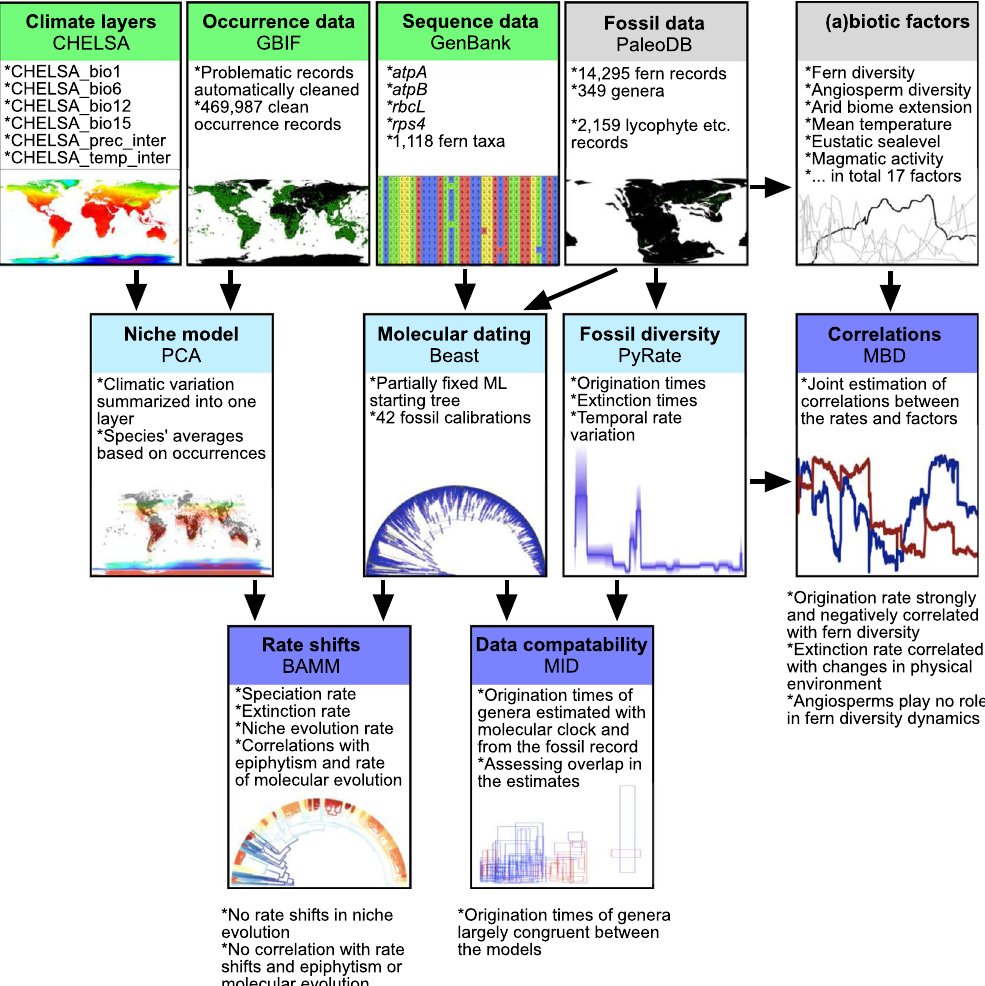
Figure 1. Analytical workflow developed for this study. We used neontological (green) and palaeontological (grey) data sources to model fern diversification dynamics. In the first round of analyses (pale blue) we summarized climatic layer information for each species, built a time-calibrated molecular phylogeny, and estimated origination and extinction times of fern genera using the fossil record. These analyses provided data for the final analyses (blue) where we tested whether the rate variation observed in the phylogeny and fossil record were correlated with various candidate biotic and abiotic factors, niche and molecular evolution, and life form. We also estimated data compatability between the neontological and palaeontological models. Maps of modern world were created using QGIS v. 2.0.1 (http://www.qgis.org) and the statistical programming language R 84 , the paleomap is based on PALEOMAP Global Plate Tectonic Model 85 and was created using Adobe Photoshop CC 2015, PointTracker 86 and QGIS v. 2.0.1